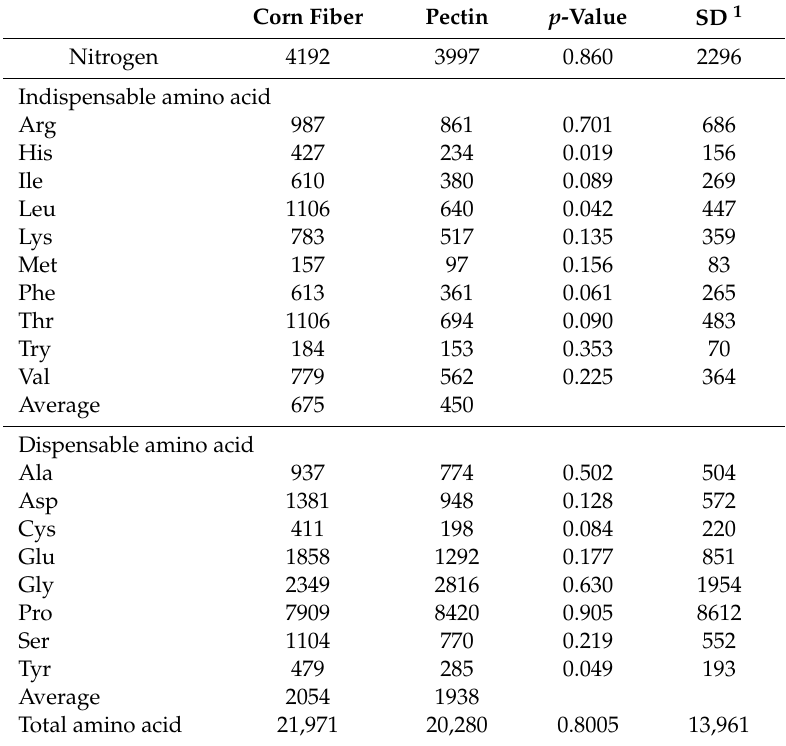
Table 7. The e ff ect of corn fiber and pectin on ileal endogenous amino acid losses (mg / kg DMI) in cannulated growing pigs (Exp.